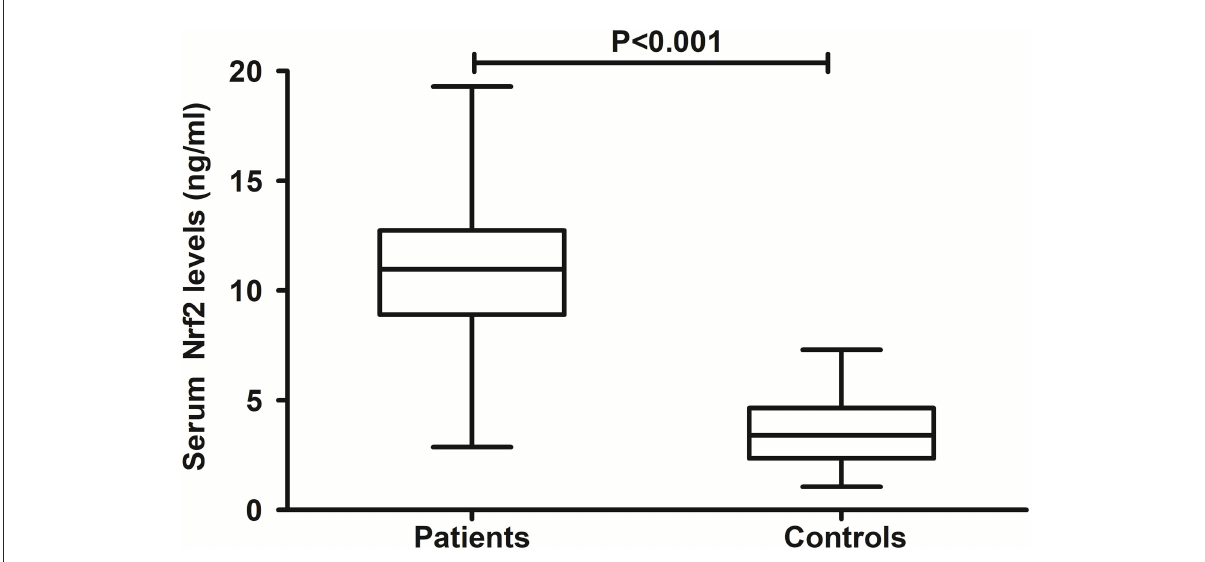
FIGURE2 Comparison of serum nuclear factor erythroid 2-related factor 2 levels between controls and patients with severe traumatic brain injury. Patients with severe traumatic brain injury had significantly higher serum nuclear factor erythroid 2-related factor 2 levels than healthy controls ( P < 0.001). Nrf2 means nuclear factor erythroid 2-related factor 2.